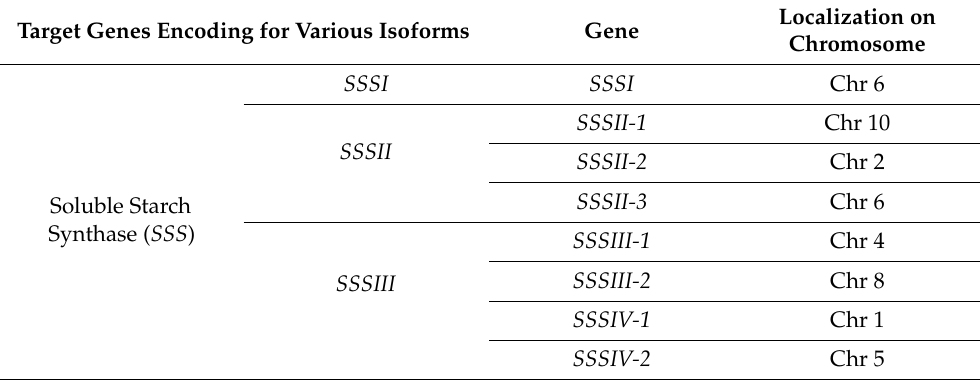
Table 3. List of the genes encoding Soluble Starch Synthases (SSS) that have been targeted in the present study using gRNA and CRISPR-Cas9 tools to create knockout mutants. Target Genes Encoding for Various Isoforms Gene